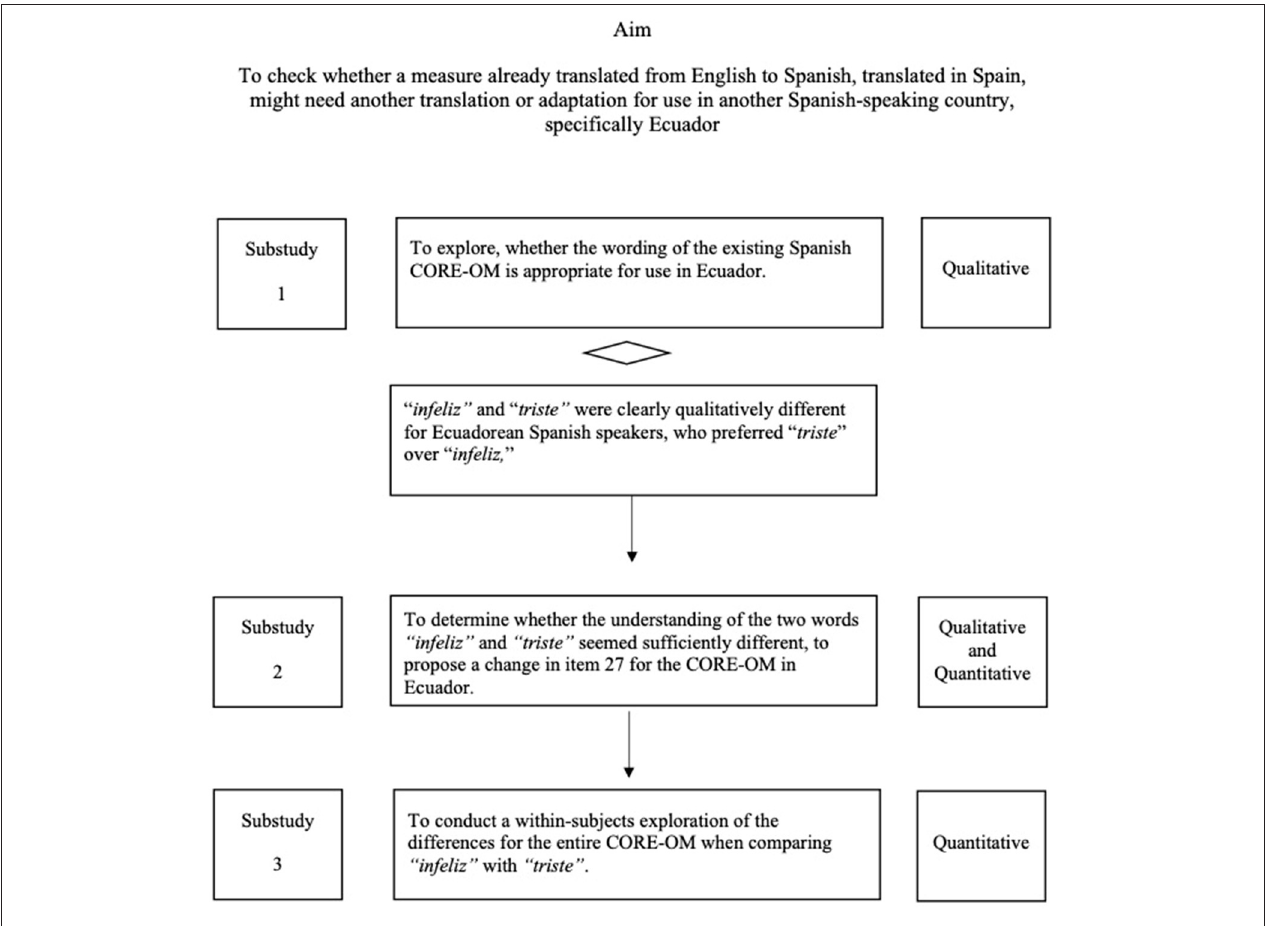
FIGURE 1 | Aim, process, and type of approach of each